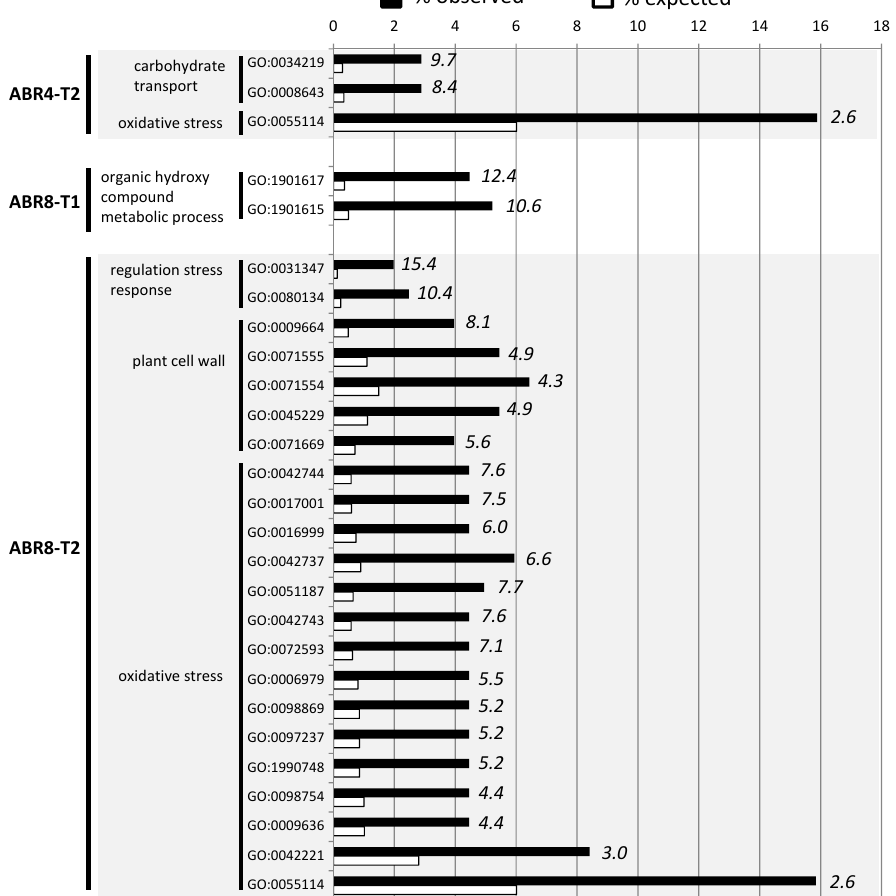
Figure 4 . GO term enrichment analysis (p < 0.05 FDR corrected) for biological processes of genes >2 fold up or down-regulated in ABR4-T2 , ABR8-T1 and ABR8-T2. For each GO term, the expected (white bars) and the observed (black bars) percentage is presented. Numbers in italics indicate the fold enrichment. Only GO-terms with more than 2-fold enrichment are shown. See Figure S3 and S4 for the results of the GO-term enrichment analyses for KOZ1-T1 and KOZ1-T2, respectively.